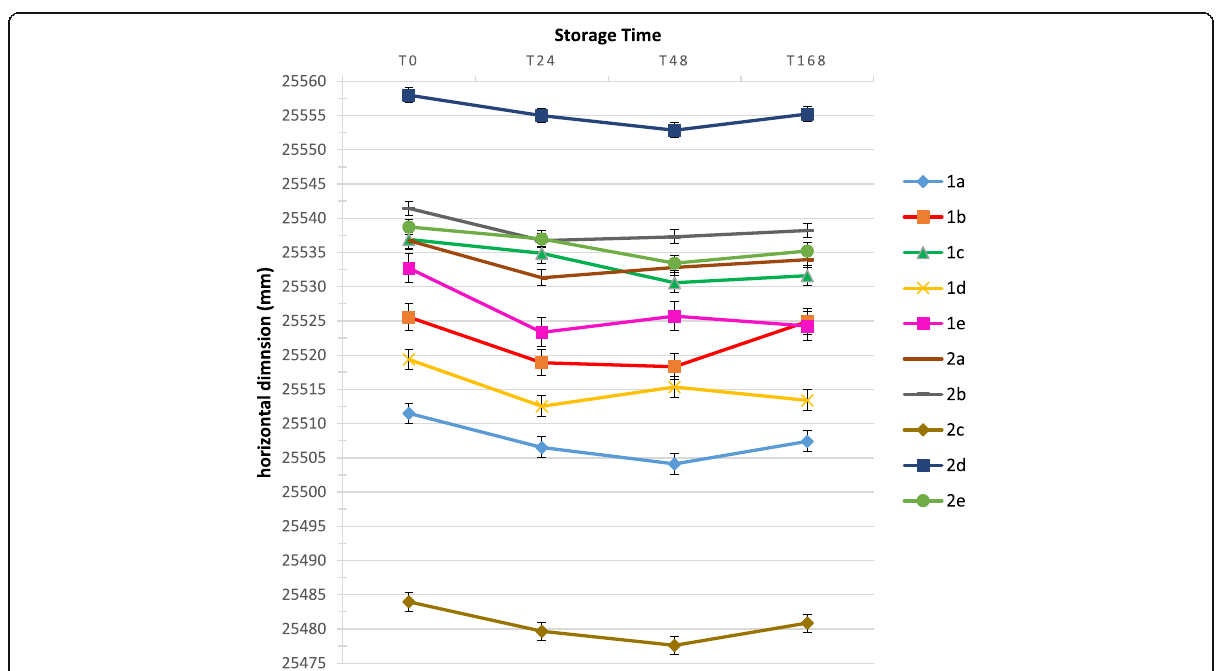
Fig. 4 Horizontal dimension for all groups analyzed at all storage